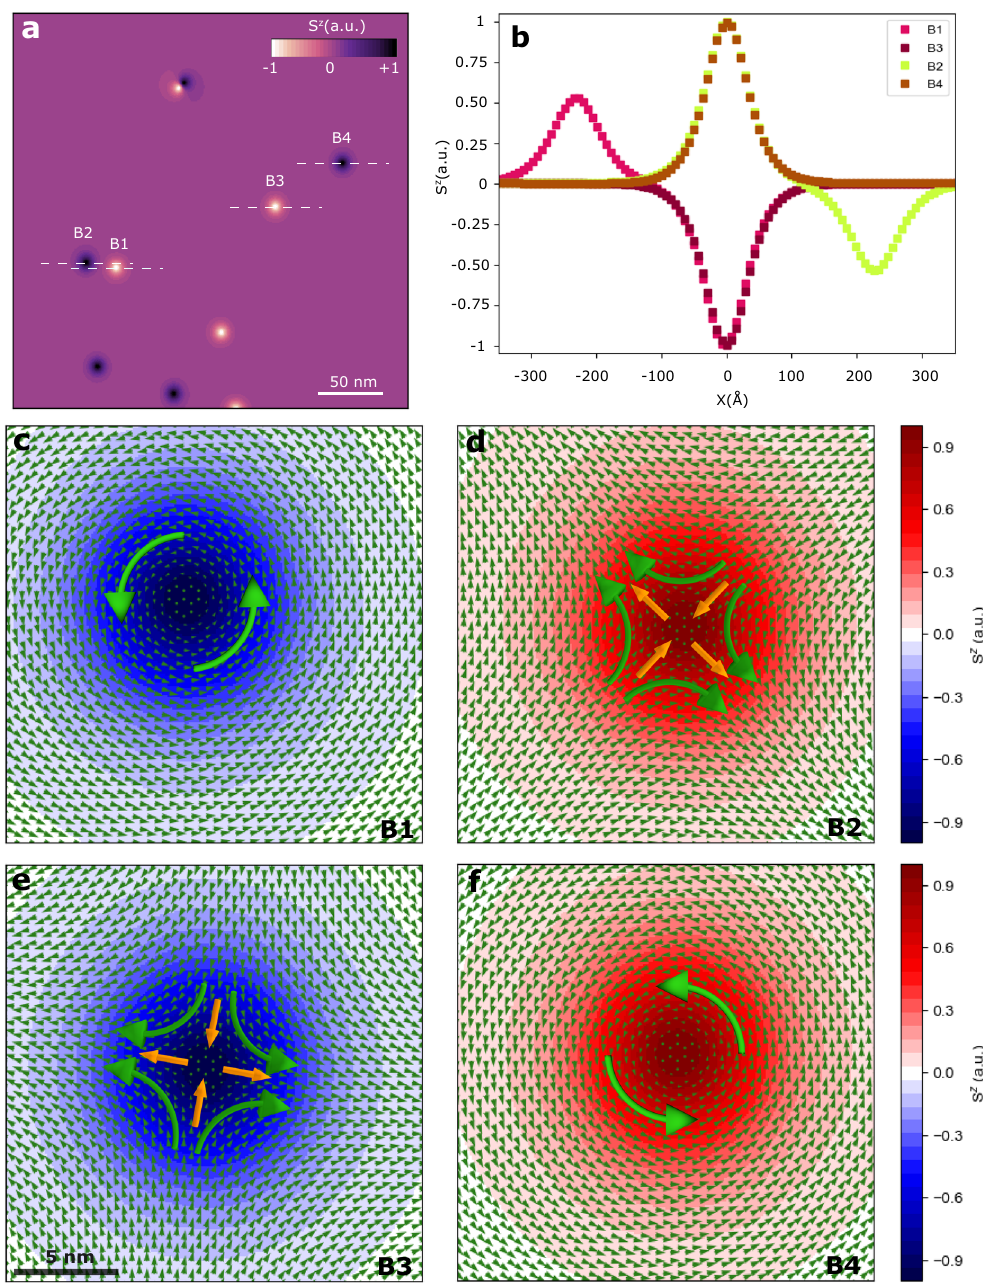
Fig. 2 Characterizing the spin features of merons and antimerons. a Snapshot of a spin con fi guration projected along the S z component (color map) at a selected time with the formation of merons and antimerons at zero magnetic fi eld and 0 K. Some of the topological spin textures are marked as B1 – B4 to highlight their features. b Pro fi le of S z along the dashed lines in a over the distinct spin quasiparticles (B1, B2, B3, B4) showing their widths in Å ’ s. B1 and B2 are close enough to feel the opposite spin polarization from each other. The largest peak at 0 Å is centered at the center of the meron or antimeron. B2 and B4 have both positive spin polarization with similar peak magnitude at 0 Å ( S z = + 1), which is the opposite of B1 and B3. c – f Spin textures of the different quasiparticles stabilized in monolayer CrCl 3 . Merons ( c , d ) and antimerons ( e , f ) can be determined by the topological number N (Eq. (4)), which involves the vorticity (±1) and the core polarization. B1 and B4 have the same vorticity of + 1 even though they are meron ( N = − 1/2) and antimeron ( N = + 1/2), respectively. Similar argument applies to B2 and B3, that is, both have vorticity of − 1 but are meron and antimeron, respectively. Small arrows (green) indicate the direction and magnitude of the in-plane magnetization relative to the core (zero value). The underneath color gradient shows the variation of S z around the spin textures. It reaches its maximum magnitude at the core of the merons and antimerons. Large arrows (orange and green) give the average behavior observed around the vortex core by the in-plane magnetization to out-of-plane. This stabilizes new cores for both complicated spin arrangement into the easy-plane of CrCl 3 with spin textures following the original core polarization at large an emission of a spin-wave 27,28 (Supplementary Movie S4). In the case of merons and antimerons with similar core polarization separations. At close distances (roughly 2 lattice constants) both (Fig. 3d – f and Supplementary Movie S5), there is an enlargement vortex and antivortex reduced gradually dissolving the